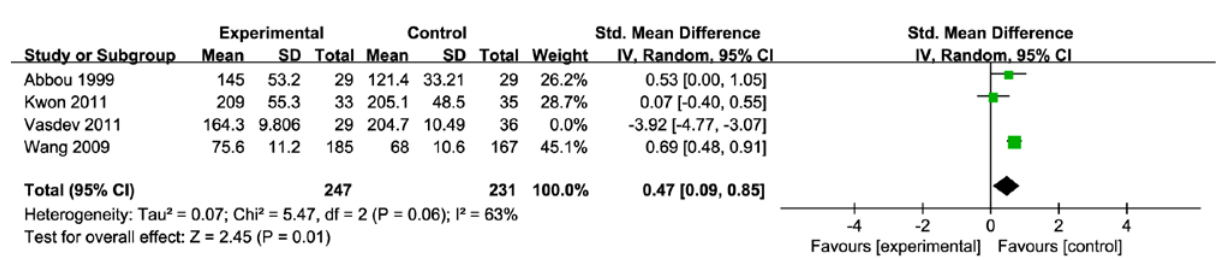
Figure 2: The forest plot for the operating time between LRN and ORN